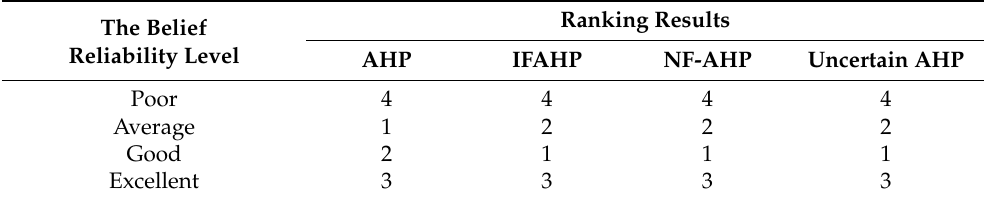
Table 12. Ranking results using different